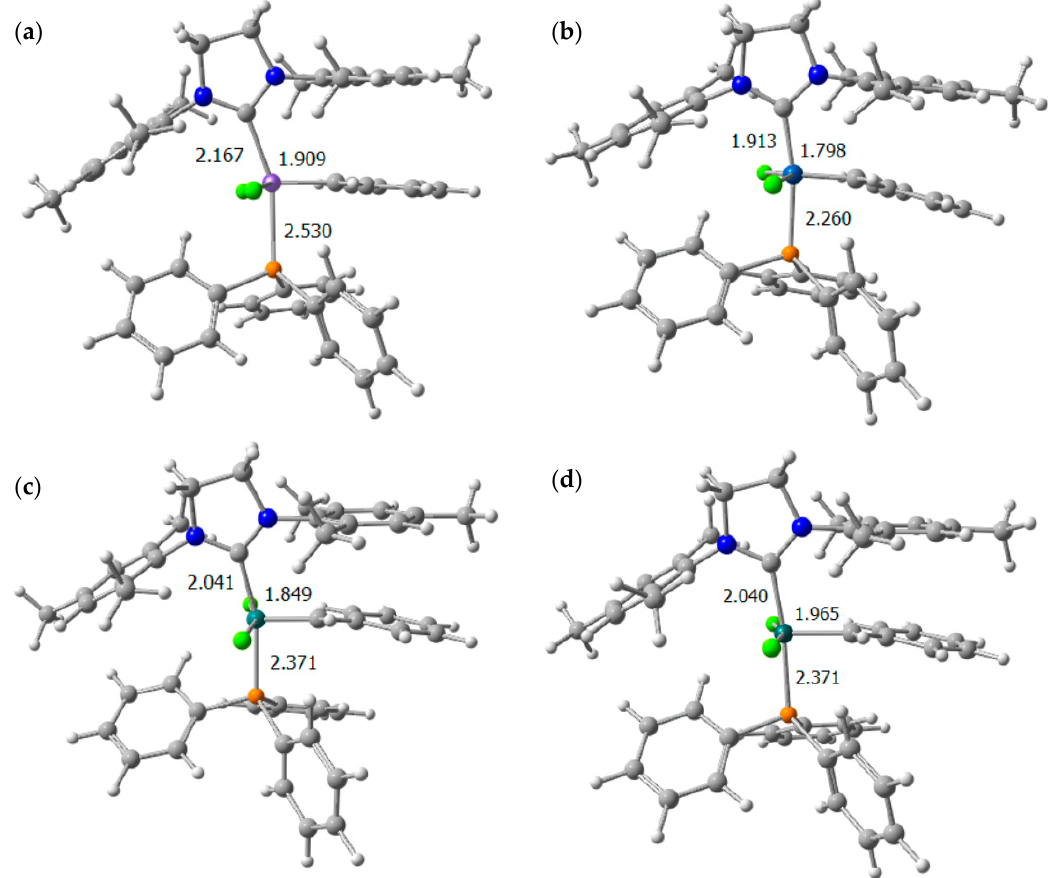
Figure 2. Computed structures for Complex I with ( a ) Fe, ( b ) Co, ( c ) Ru, and ( d ) Rh as the metal center. Selected distances are given in Å.